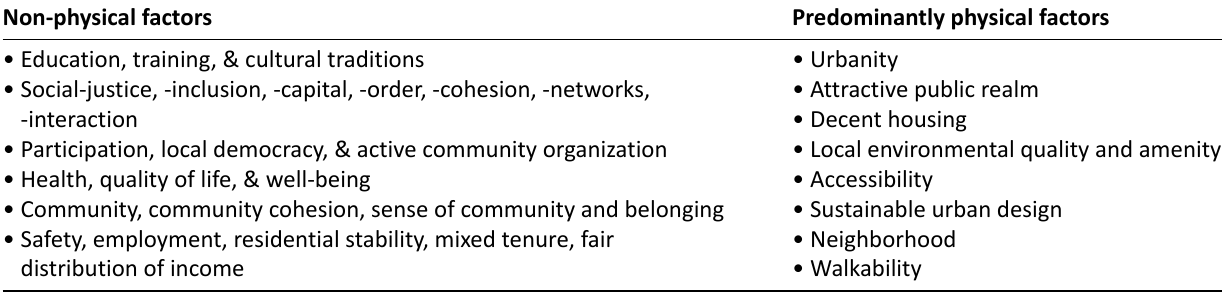
Table 1. Contributing factors to urban social